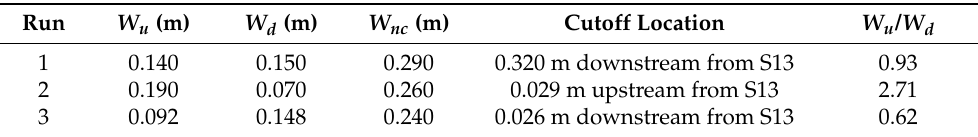
Table 2. Scour distances upstream and downstream of the